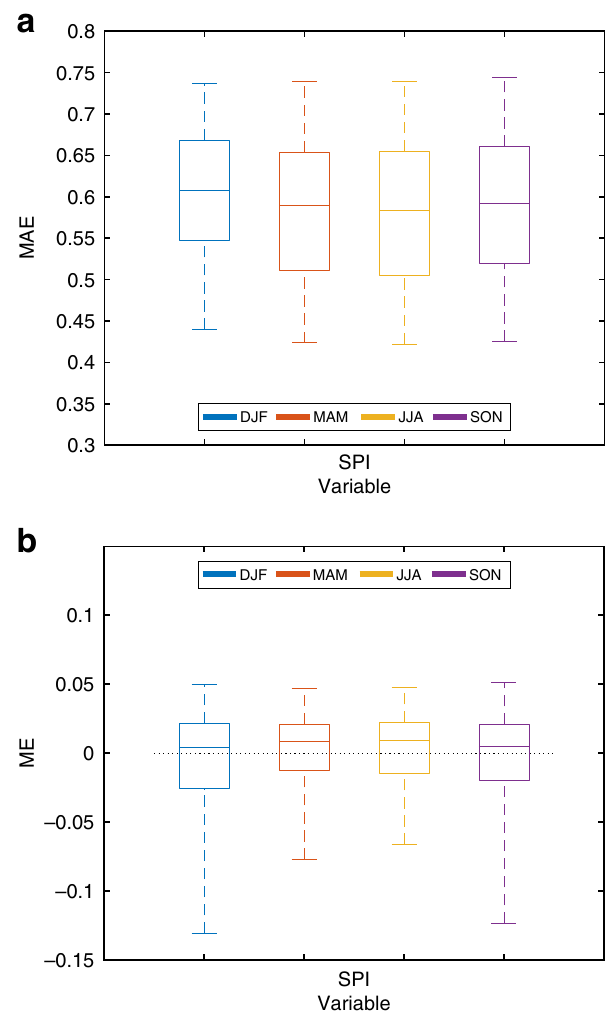
Fig. 6 Veri fi cation summary of burned area predictions obtained from the seasonal forecast ensemble BESTENS. Boxplots of the spatial distribution of the a mean absolute error values (MAE) and b mean error values (ME) for the burned area predictions using seasonal forecasts of SPI based on the BESTENS for the four seasons (depicted with different colours). The median is shown as a solid line, the box indicates the 25 – 75 percentile range while the whiskers show the 2.5 – 97.5 percentile